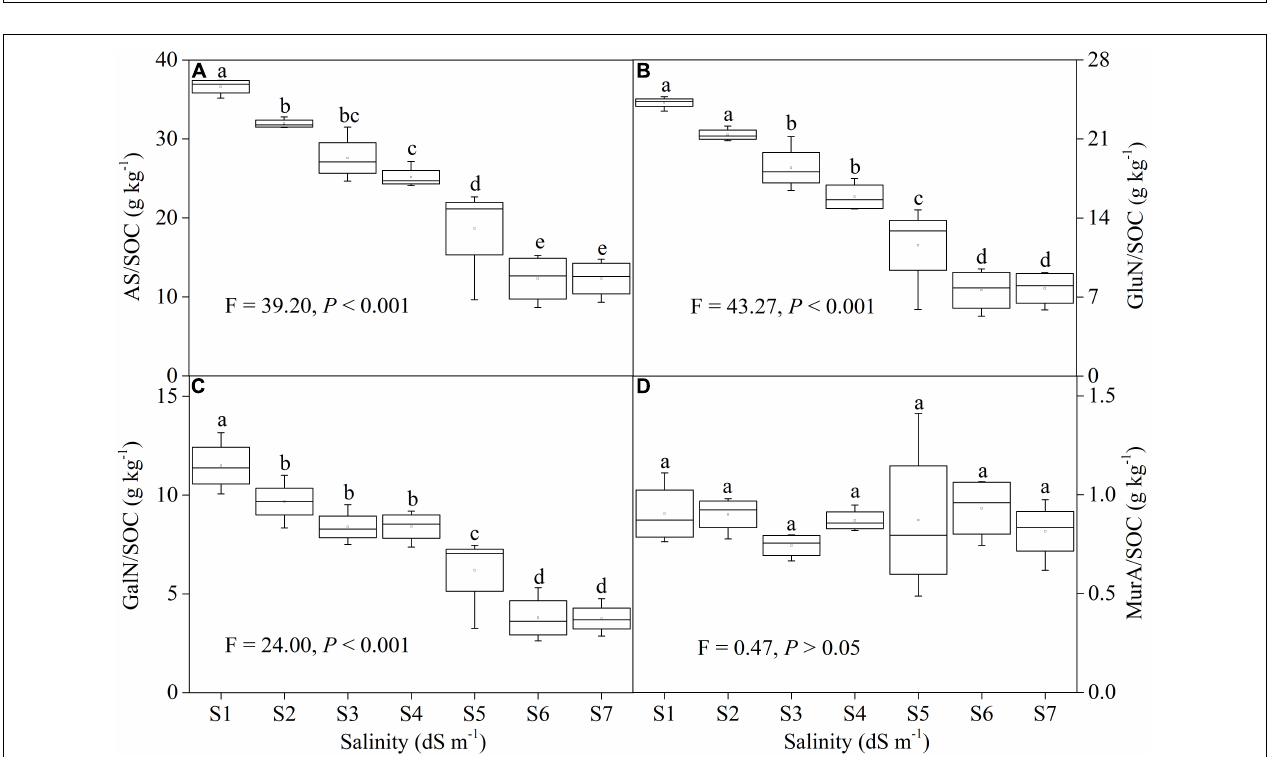
FIGURE 3 | The ratio of total AS (A) , GluN (B) , GalN (C) , and MurA (D) to SOC across a soil salinity gradient.